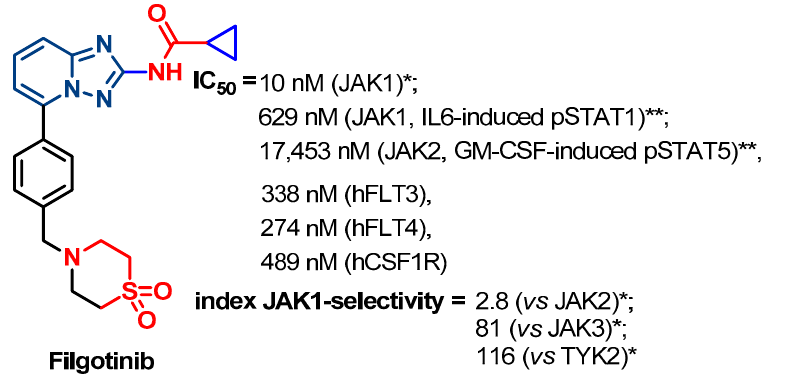
Figure 33. Kinase inhibitor activity of filgotinib and its active metabolite, * indicates the IC 50 and index selectivity values determined using recombinant JAKs, ** indicates the IC 50 values determined using a human whole blood assay [116,117].